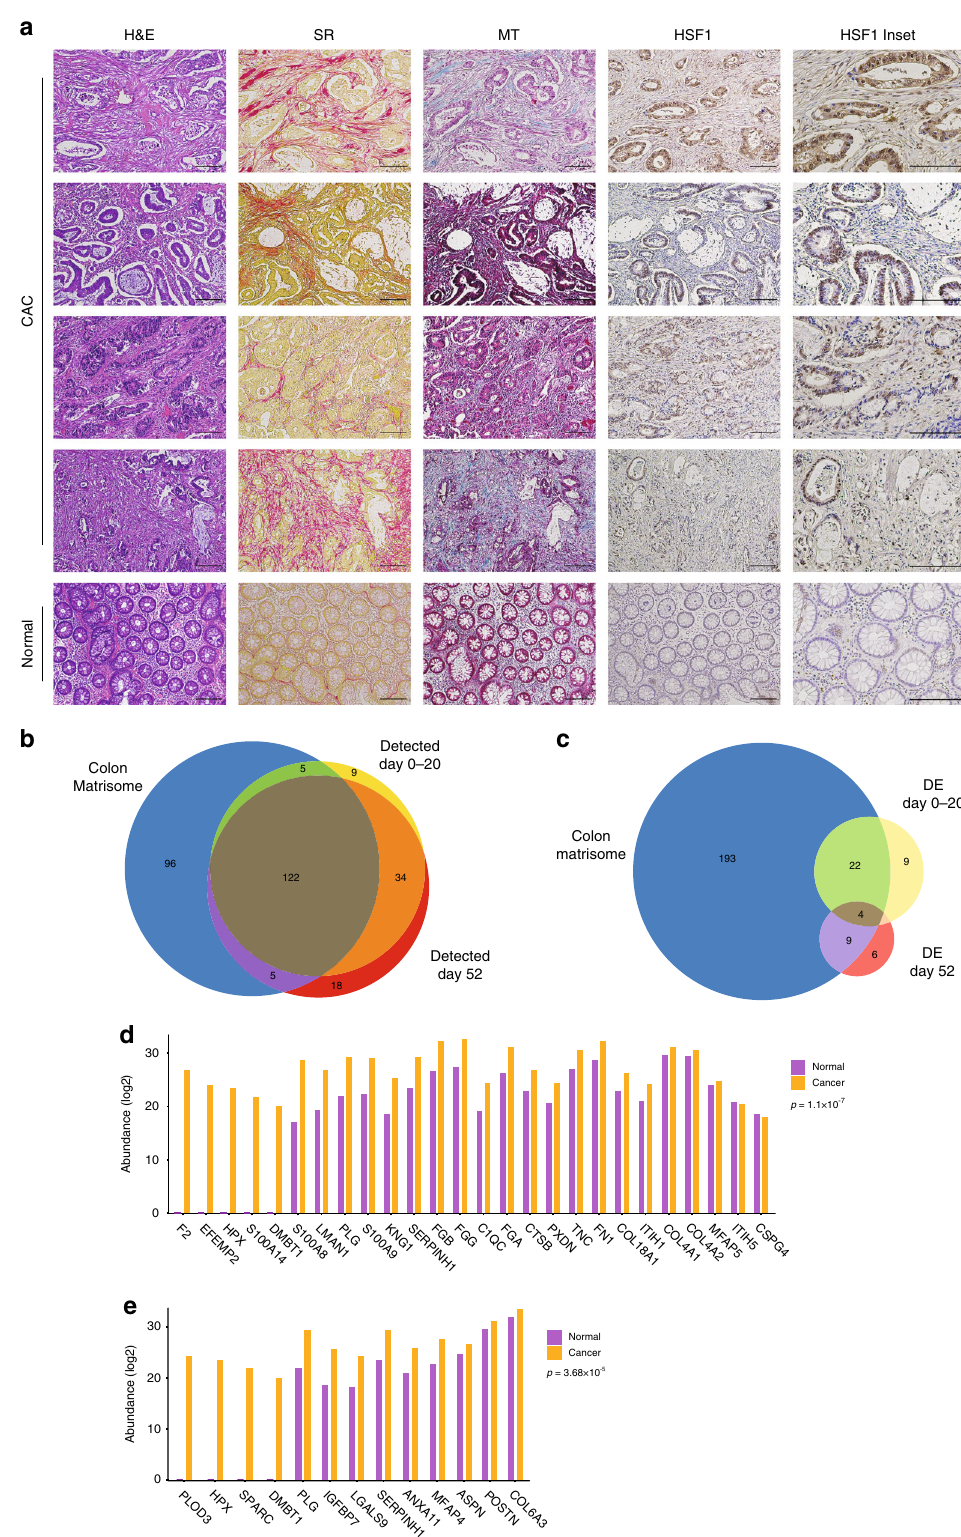
Methods Ethics statement . All clinical samples and data were collected following approval by the Sheba Medical Center Institutional Review Board (IRB, protocol # 6141-19- SMC and SMC-3305-16) and Ministry of Health (MOH) approval for the Israel National Biobank for Research (MIDGAM). All animal studies were conducted in accordance with the regulations formulated by the Institutional Animal Care and Use Committee (IACUC; protocol # 23590116-2, 34810317-2, 03960520-2).